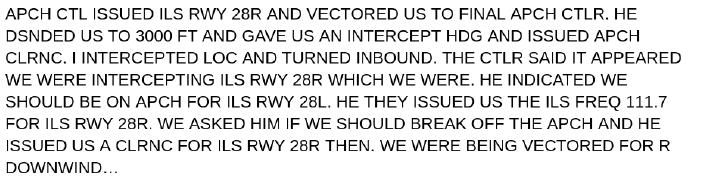
Figure 4. Extract of the narrative of an occurrence report from the 1987–2008